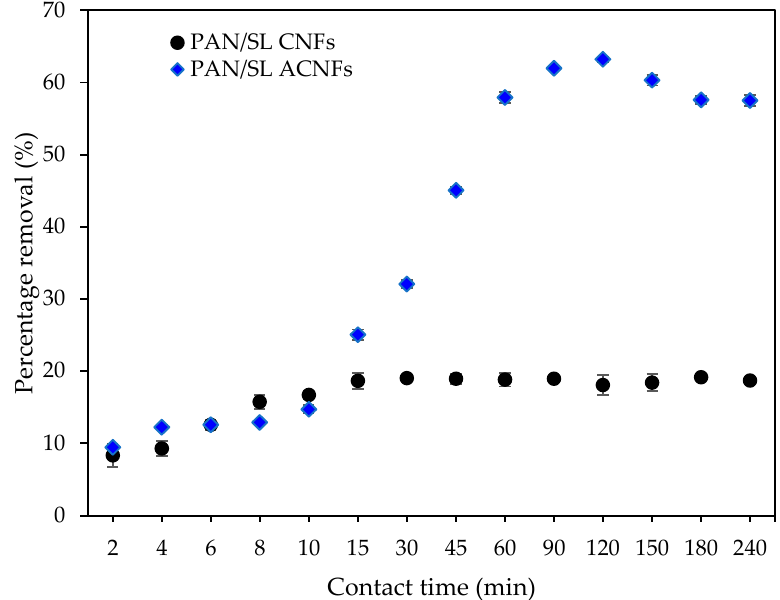
Figure 9. Percentage removal of Pb(II) ions for PAN / SL CNFs and PAN / SL ACNFs. Conditions: [Pb(II)] = 100 mg / L, dosage of adsorbent = 25 mg, pH = 5.